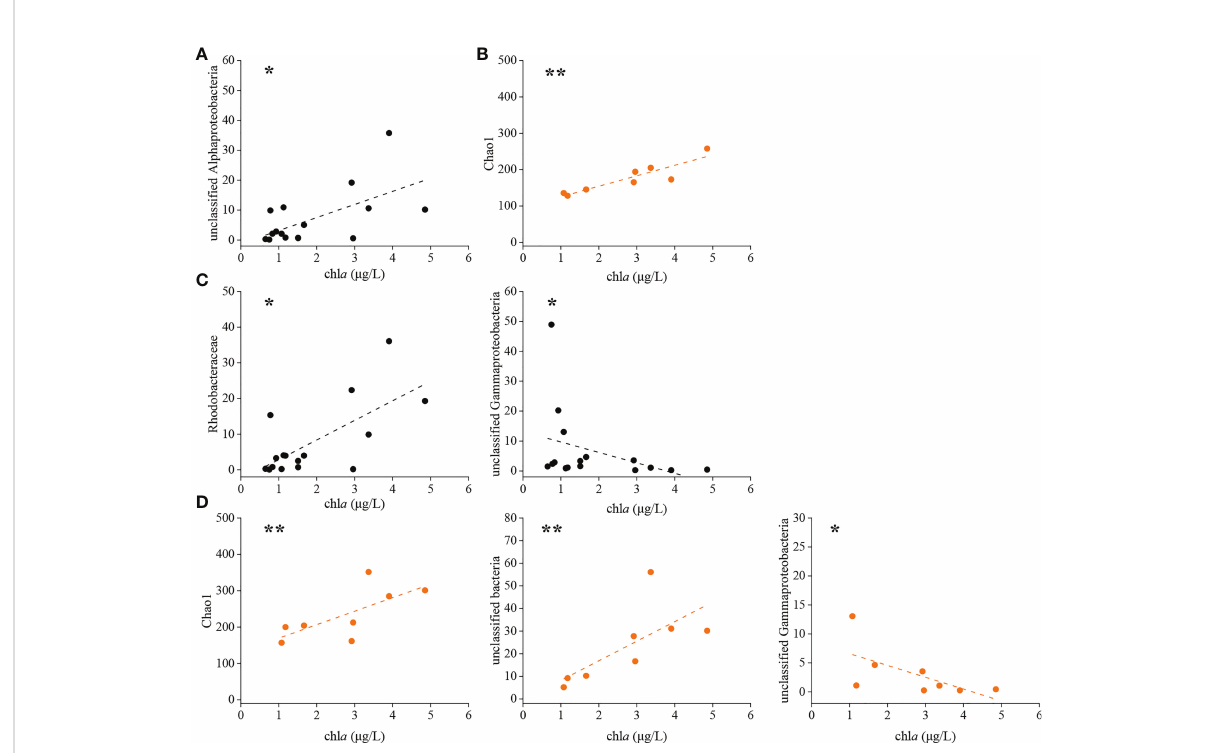
FIGURE 6 Signi fi cant relationships between chl a content and the nirK -type denitrifying bacterial community during the green tide (A) and the outbreak phase (B) , and the nirS -type denitrifying bacterial community during the green tide (C) and the outbreak phase (D) . * P < 0.05, ** P <